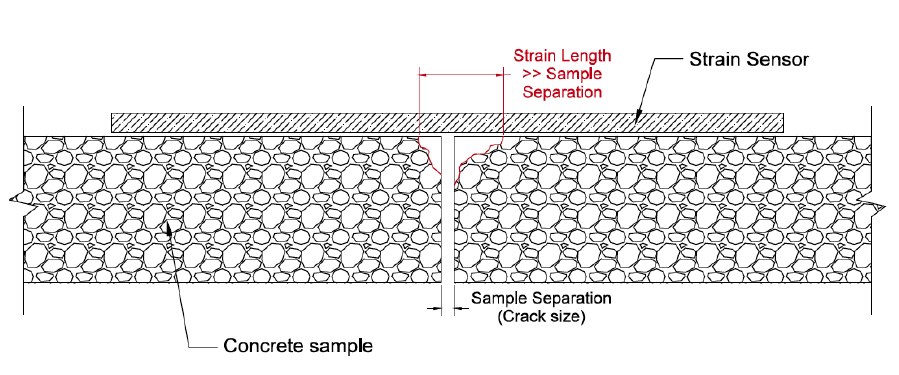
Figure 4. Strain length vs. sample separation on degrading materials. Degradation is indicated by red